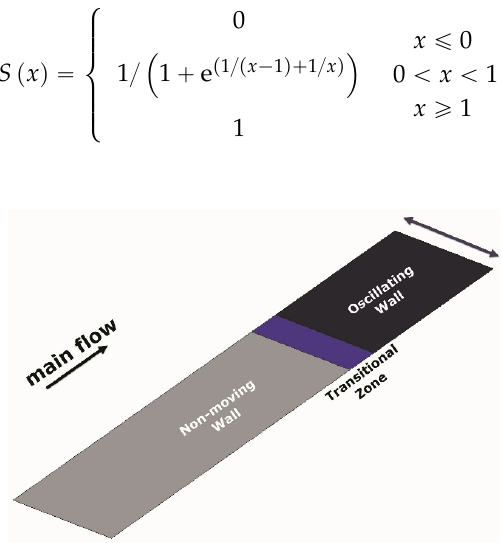
Figure 1. Sketch of the boundary layer flow with spanwise wall oscillation (SWO).